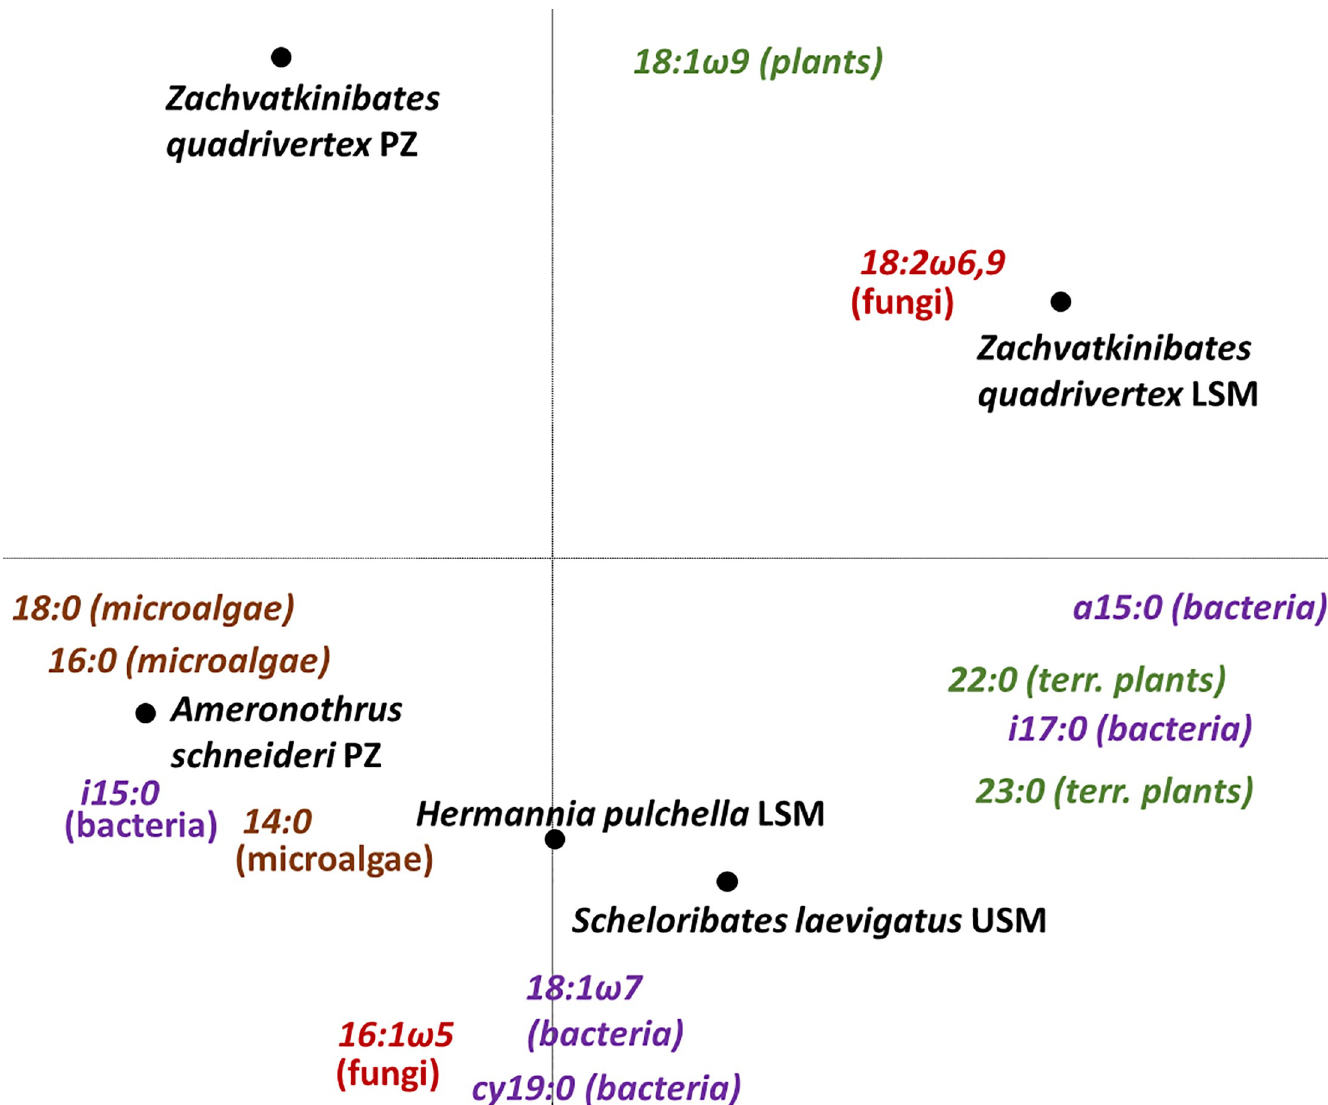
Fig 4. Principal components analysis (PCA) of oribatid mites ( Scheloribates laevigatus , Hermannia pulchella , Zachvatkinibates quadrivertex , Ameronothrus schneideri ) from three salt marsh zones [upper salt marsh (USM), lower salt marsh (LSM), pioneer zone (PZ)] and the body tissue fatty acids 18:1 ω 7, 18:1 ω 9t, i15:0, i17:0, cy19:0, 16:1 ω 5, 18:2 ω 6,9, 18:1 ω 9, 18:3 ω 3, 18:2 ω 6t, 22:0, 23:0, 14:0, 16:0 and 18:0. Eigenvalues of axes 1 and 2 of 0.66 and 0.23, respectively (length of gradient: 1.3). Different colors indicate different fatty acid biomarkers: bacterial markers (purple), fungal markers (red), plant markers (green), microalgal markers (brown).